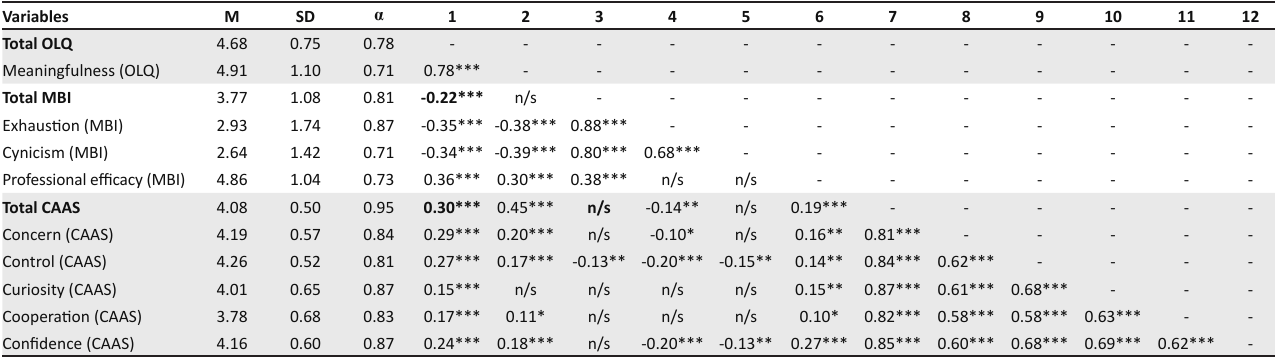
TABLE 1: Means, standard deviations, internal consistency reliability coefficients and zero-order correlations ( N = 409). Variables M SD α Total OLQ Meaningfulness